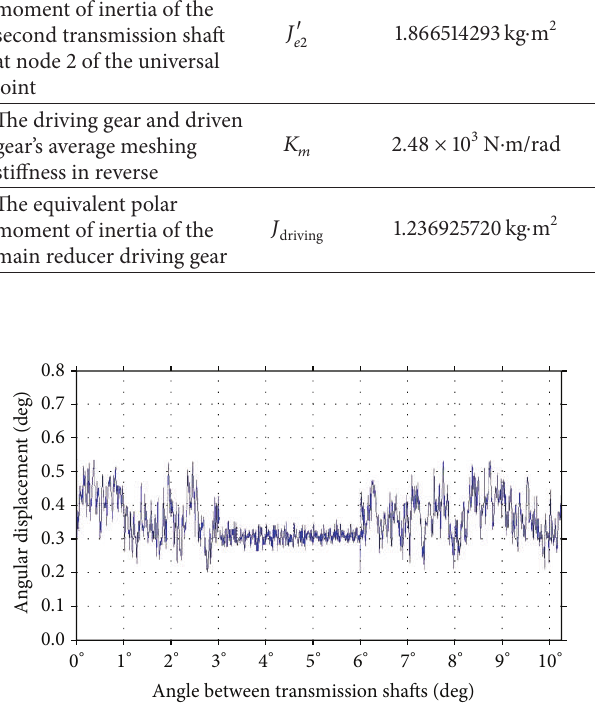
Figure 4: Response curve: driven gear angular displacement.